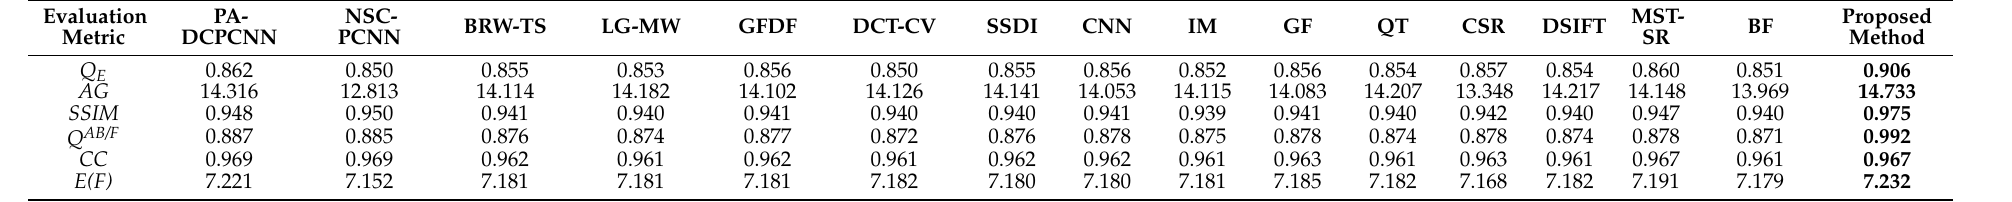
Table 22. The outcomes for the flower image and comparisons with existing techniques in the literature ([21]).